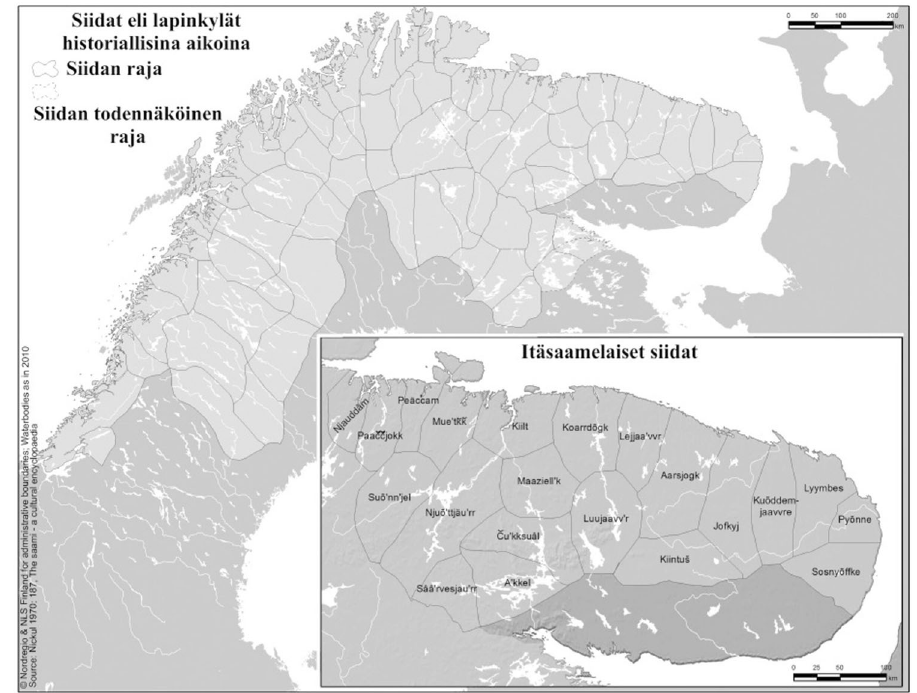
Fig. 3 Sámi historical siida territories on a map. Map by Johanna Roto/ Snowchange, 2022. Used with permission. The larger map conveys all these sites across present-day Norway, Sweden, Finland, and NW Russia. The inset map points to the Eastern Sámi siida territories, which are the subject of the case study, especially the westernmost, Njauddam — Näätämö siida , the location of the rewilding